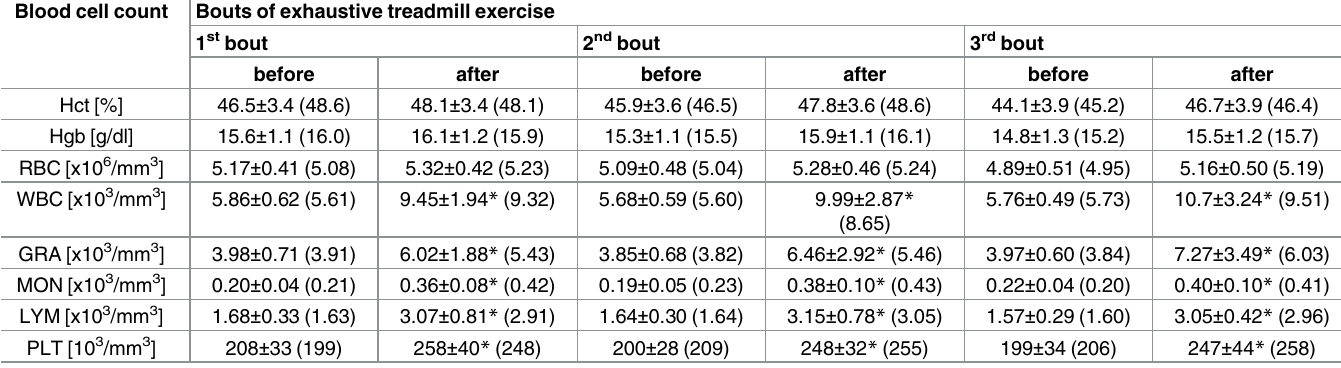
Table 2. Blood cell count in eleven average-trained men before and after each of three bouts of exhaustive treadmill exercise. Blood cell count Bouts of exhaustive treadmill